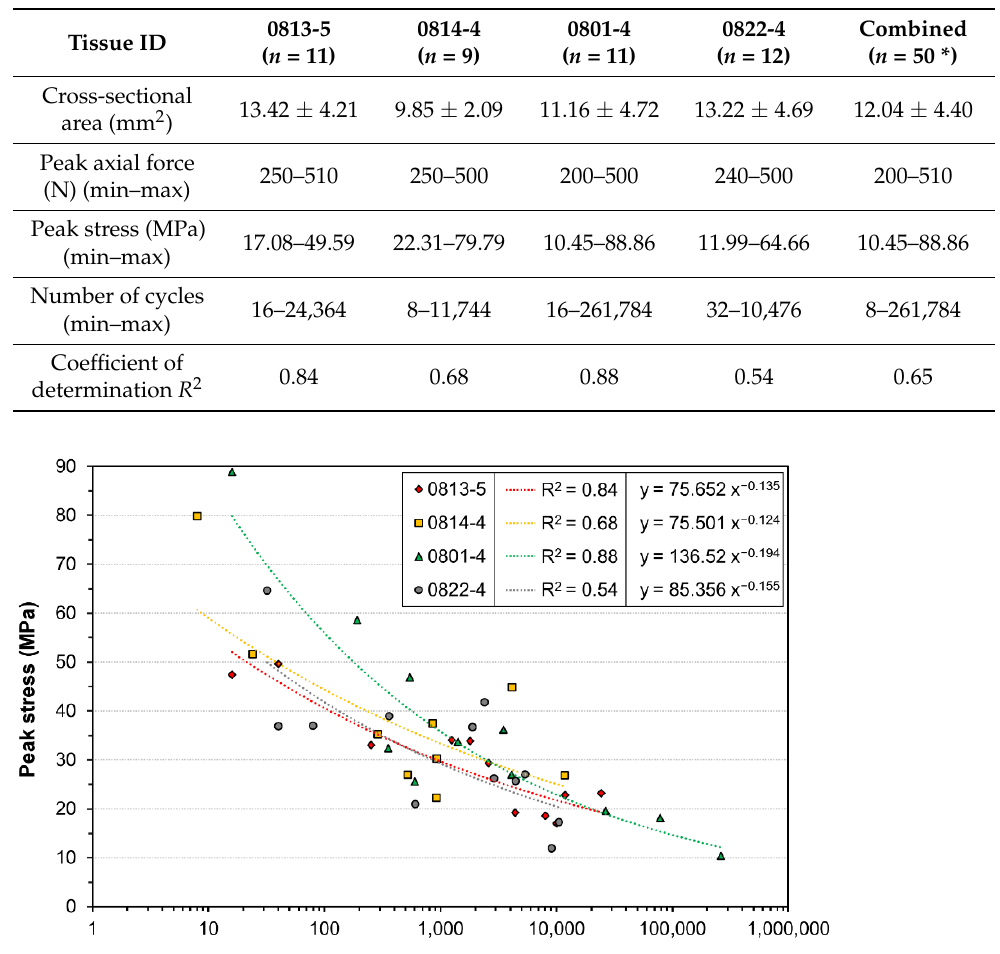
Table 1. Test results of the sample groups’ individual cadavers and combined mean values and standard deviations of the cross-sectional areas, minimum and maximum values of peak axial forces, peak stresses and number of cycles until failure, and coefficient of determination of Woehler curves obtained through power regression. * Individual values of two donors are not given due to a sample size of less than six.